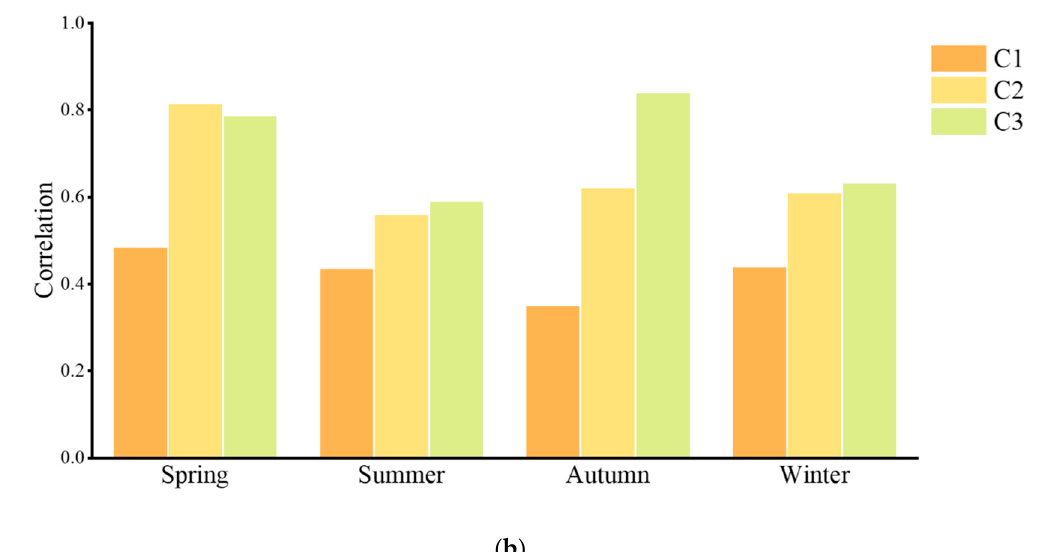
Figure 3. ( a ) Proportion of three fluorescent component (C1, C2, and C3) in the four seasons; ( b ) Pearson correlation coefficients of C1, C2, and C3 with DTT v in four seasons, respectively.